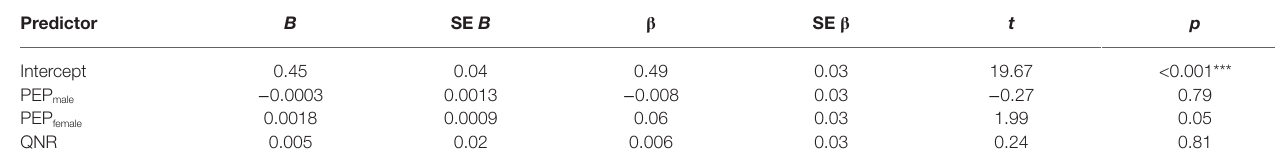
TABLE 4 | Multiple regressions of gender congruent hiring decisions on PEP- and questionnaire-based gender stereotypes in Experiment 3. Predictor B SE B